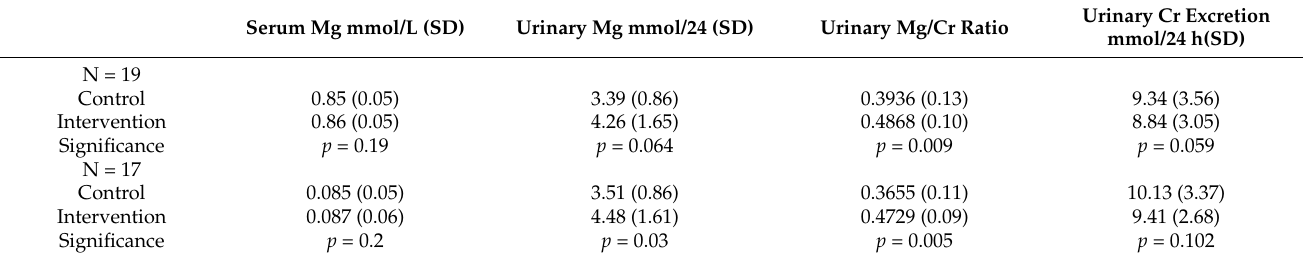
Table 3. Markers of magnesium status from baseline to post-supplementation.